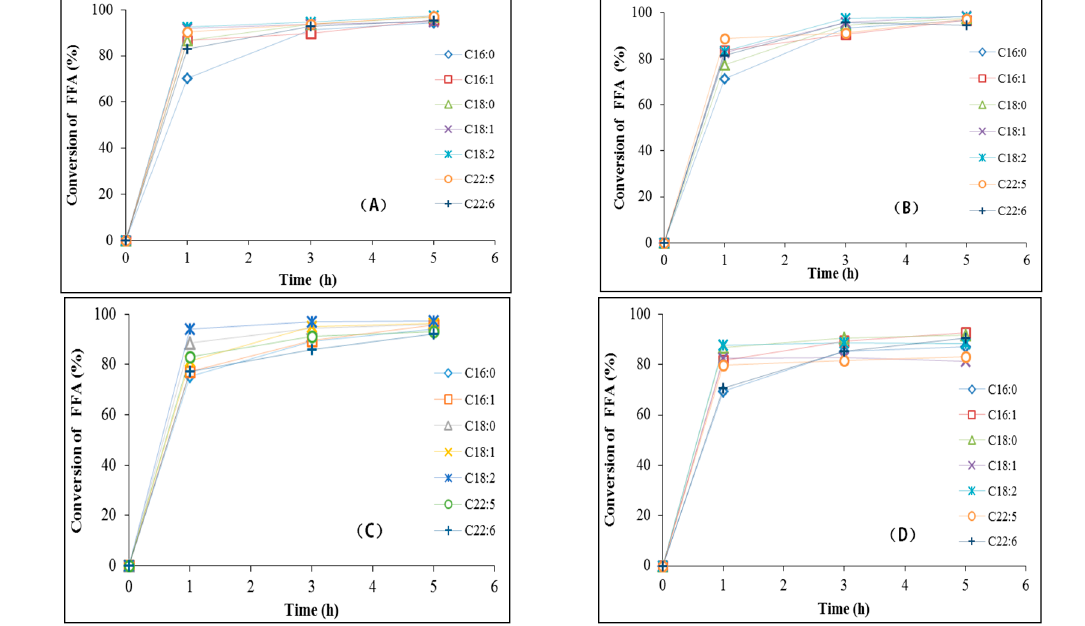
Figure 4. Free fatty acids (FFAs) change profile at different temperature. ( A ) 200 °C; ( B ) 220 °C; ( C ) 240 °C; ( D ) 260